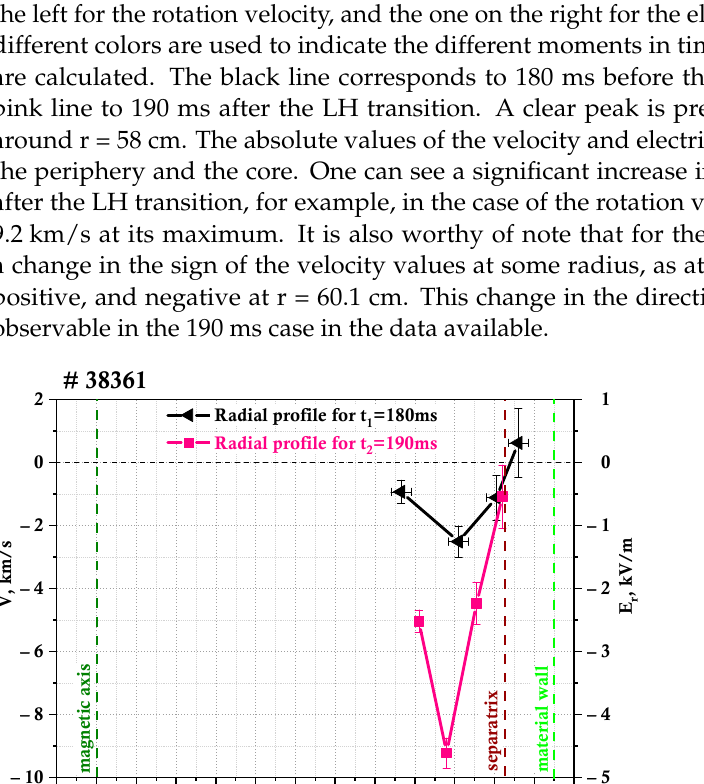
Figure 5. Plasma rotation velocity and electric field profile, measured by DBS.